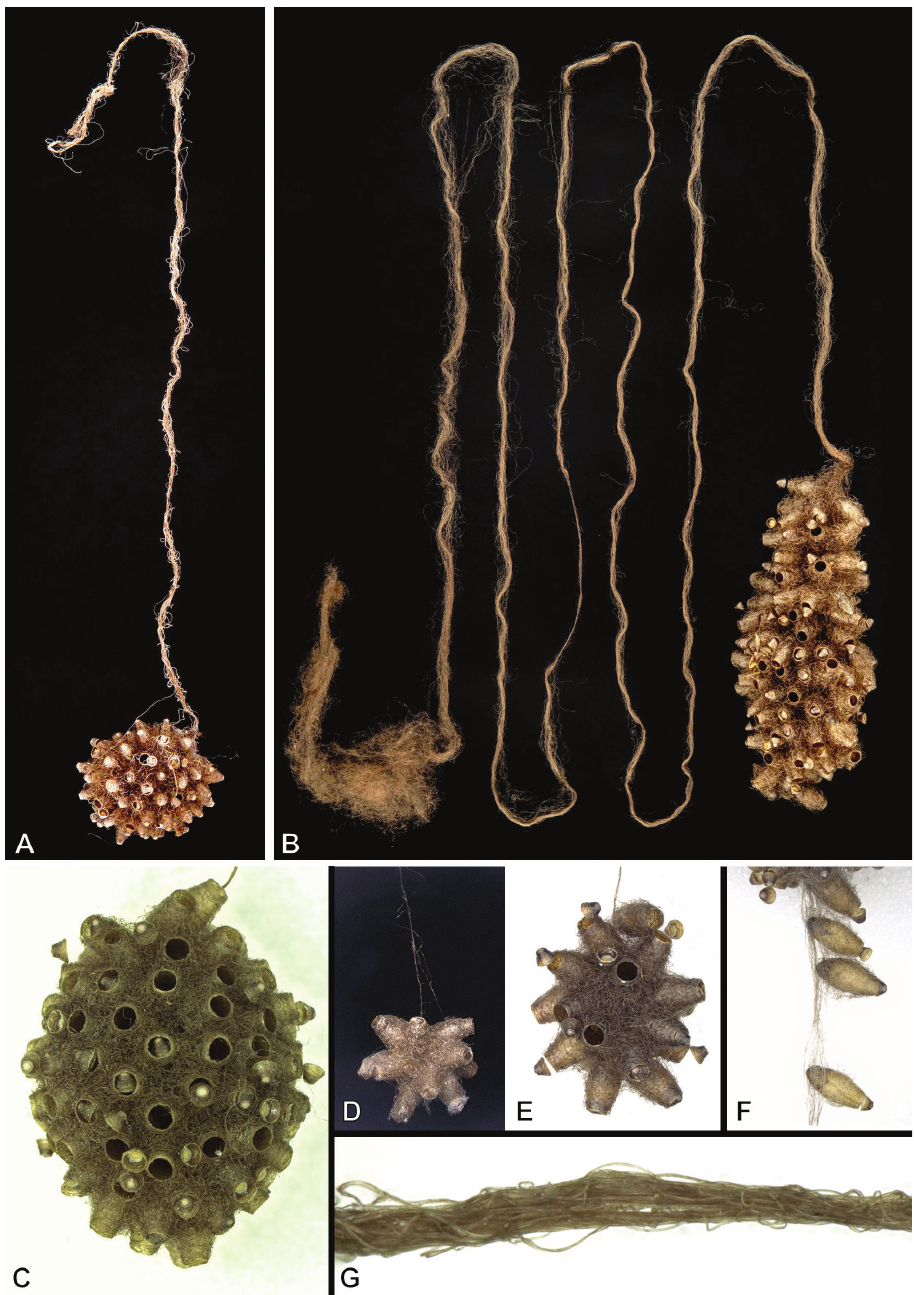
Figure 8. Cocoon masses of Meteorus stellatus sp. nov. A habitus, medium-sized B habitus, exceptionally large-sized and somewhat collapsed in an artificial condition C a medium-sized cocoon mass D, E small- sized cocoon masses F independent cocoons near a cocoon mass G a part of suspending thread, consisting of individual